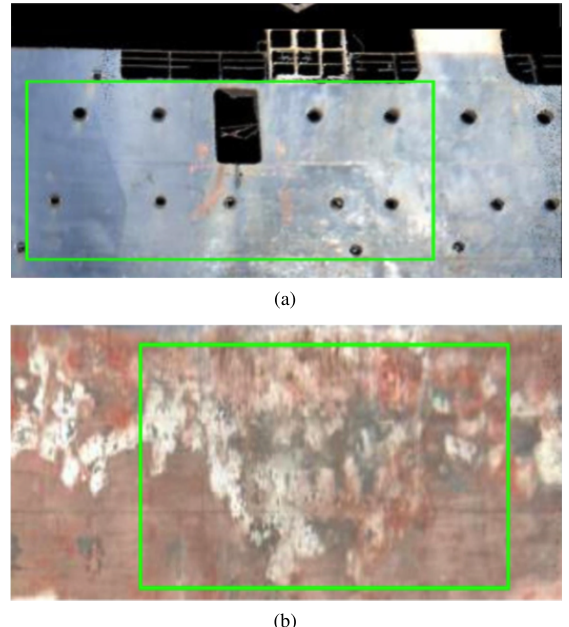
Figure 2. The two images show the zones selected by the user. (a) shows a zone with minor corrosion whereas (b) shows a zone with dominant corroded